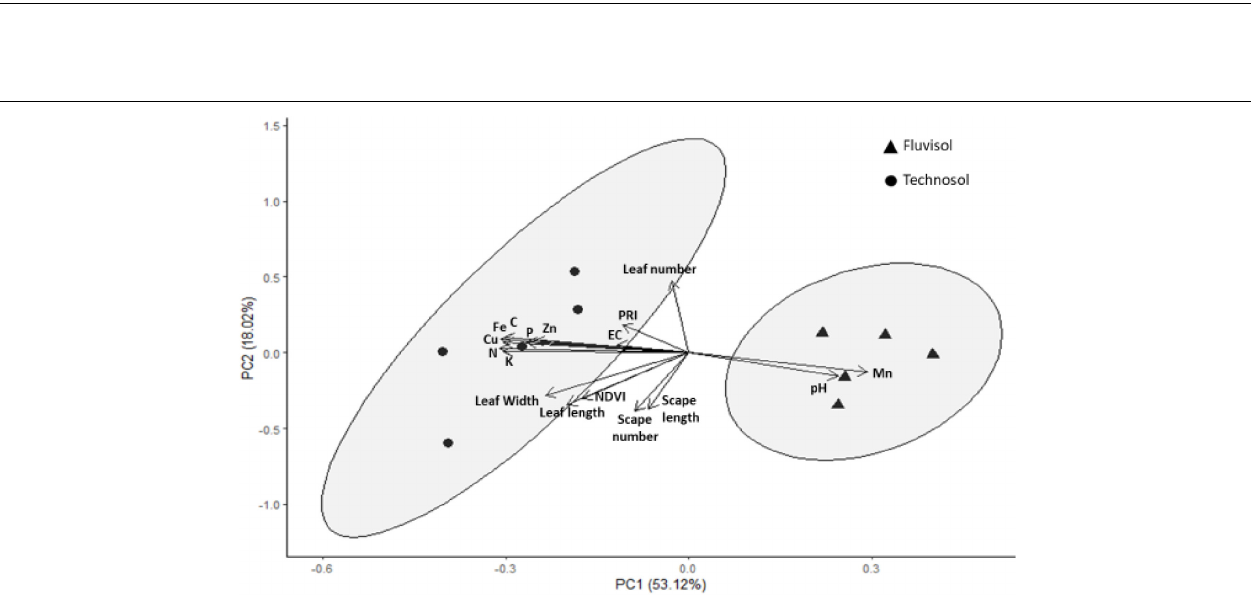
FIGURE 7 | The first two axes of Principal Component Analysis. This analysis was based on pH, CE, organic carbon (C), nutrients concentration (N total (N), extractable P (P), extractable K (K), Fe, Mn, Zn, Cu) determined in the soils in the beginning of the assay (T0) and the morphometric parameters (leaf number, leaf length, leaf width, scape number, scape length) and photosynthetic indexes [normalized difference vegetation index (NDVI) and photochemical reflectance index (PRI)] measured in plants at the end of the assay (T3). Percentages of total variance explained by the functions are given in parenthesis.